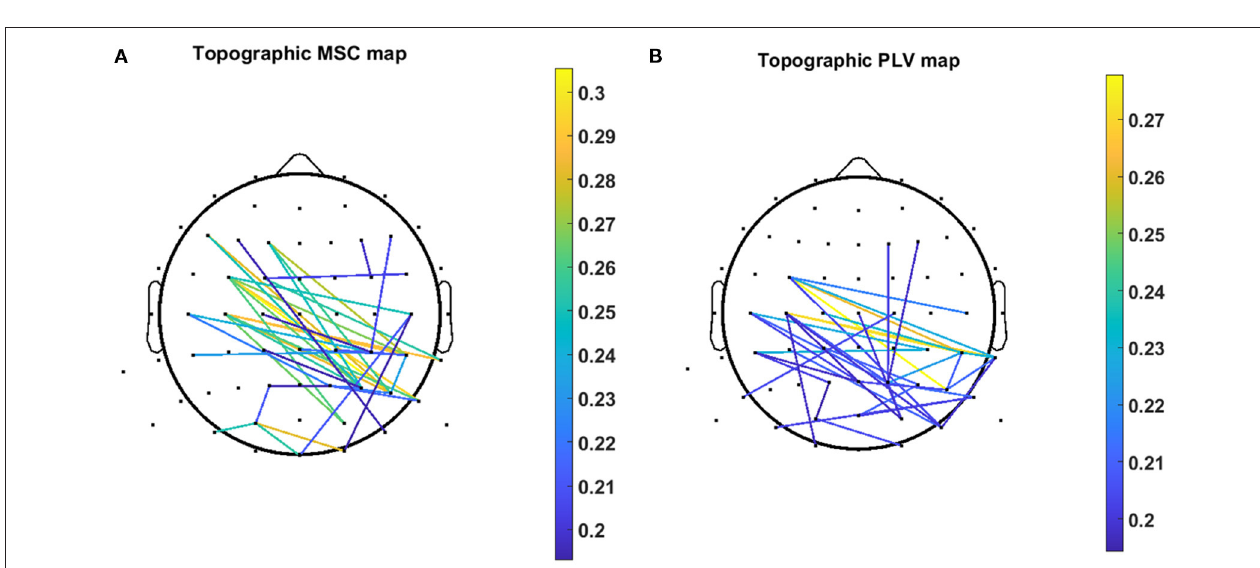
FIGURE 7 | Topographic map of 40 channel pairs with highest PCC over all subjects for (A) MSC features and (B) PLV features. Color bar represents the value of the PCC related to the specific channel pair.